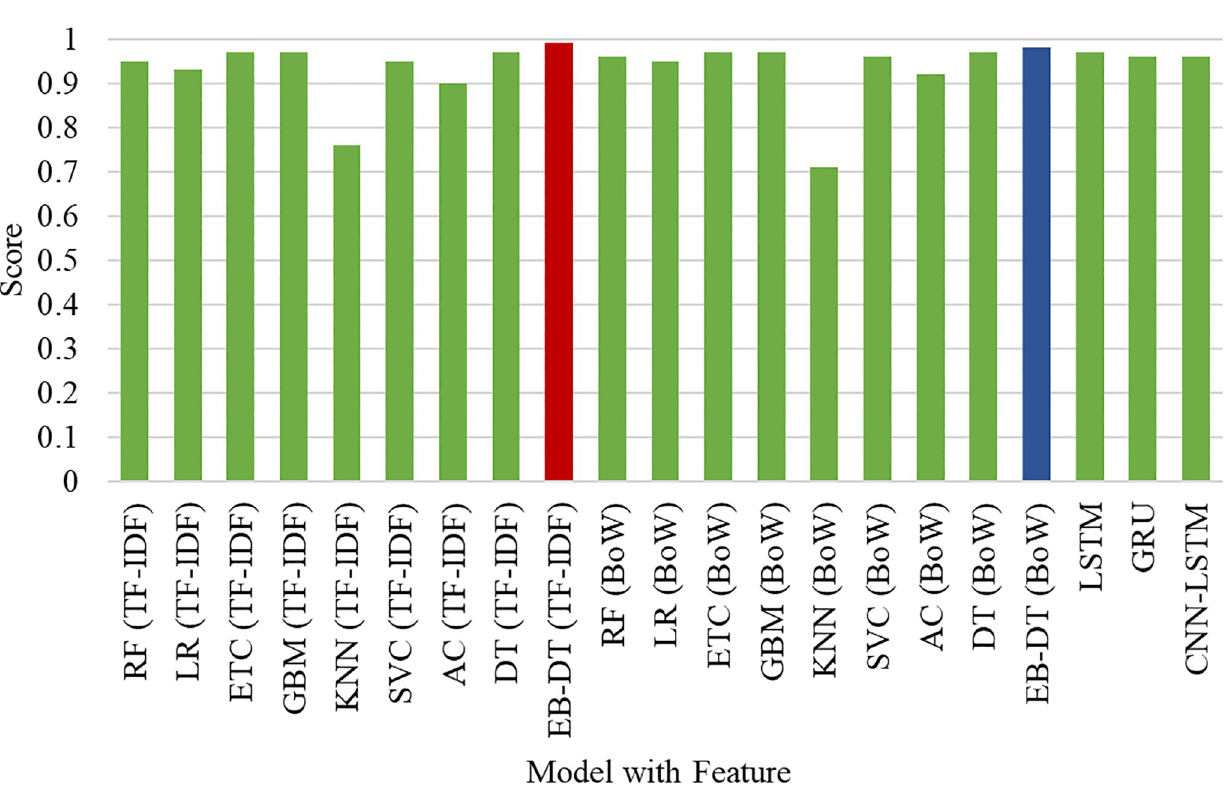
Fig 10. Performance comparison of classifiers in sentiment classification of tweets.